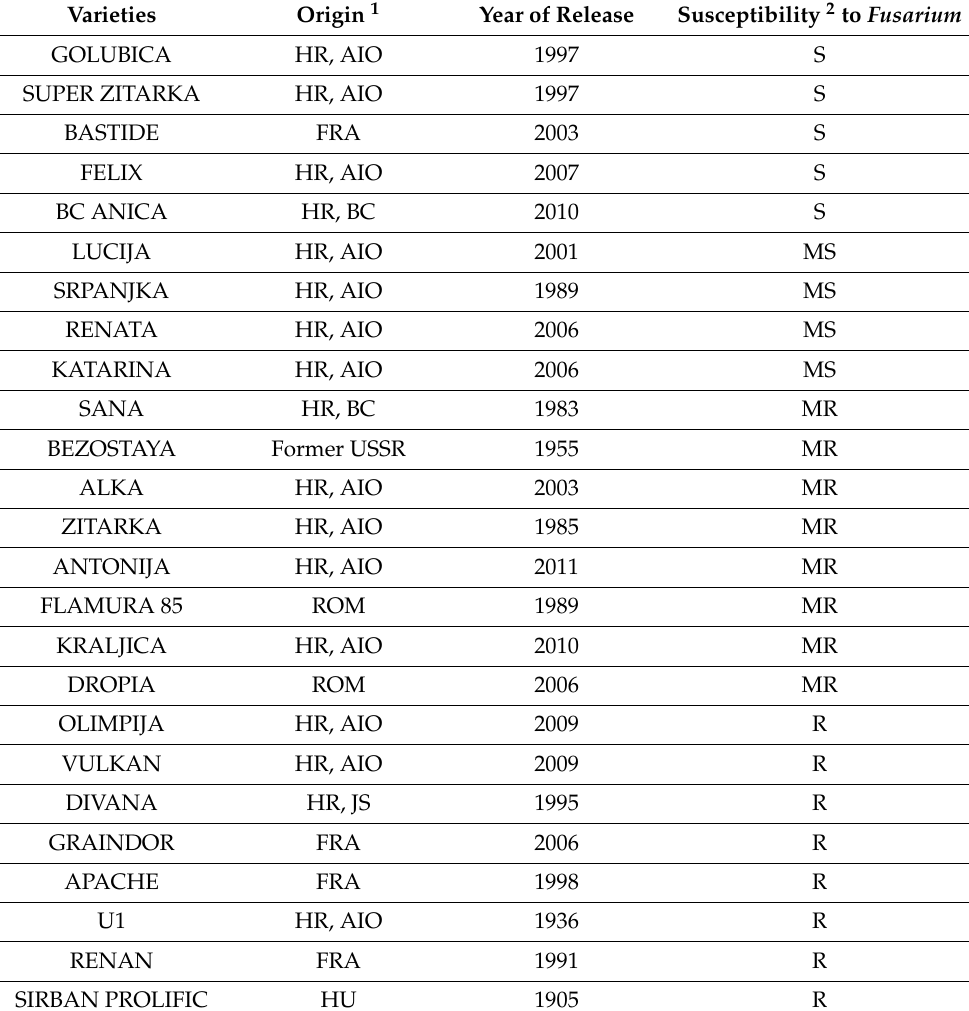
Table 1. Origin, year of release, and susceptibility to Fusarium of 25 investigated winter wheat varieties.